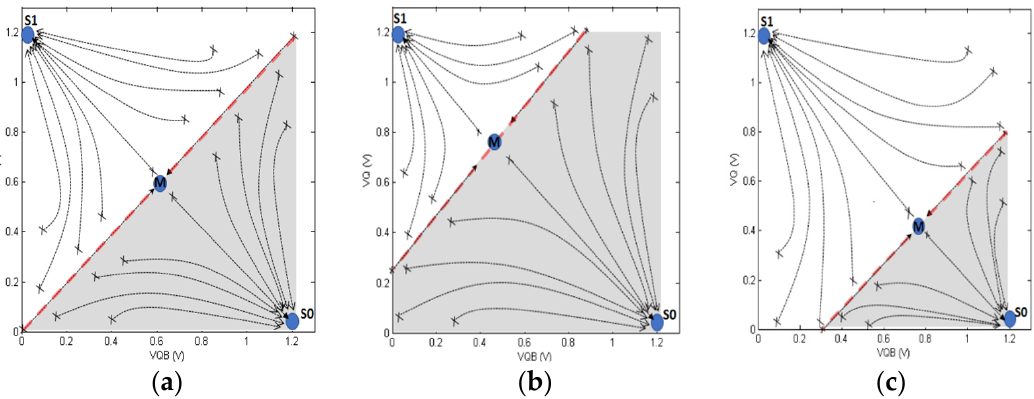
Figure 5. The phase-space of SRAM memory development at startup: ( a ) for an ideal symmetrical cell, ( b ) for an asymmetrical cell with a propensity towards logic ‘0’, and ( c ) for an asymmetrical cell with a tendency towards logic ‘1’.